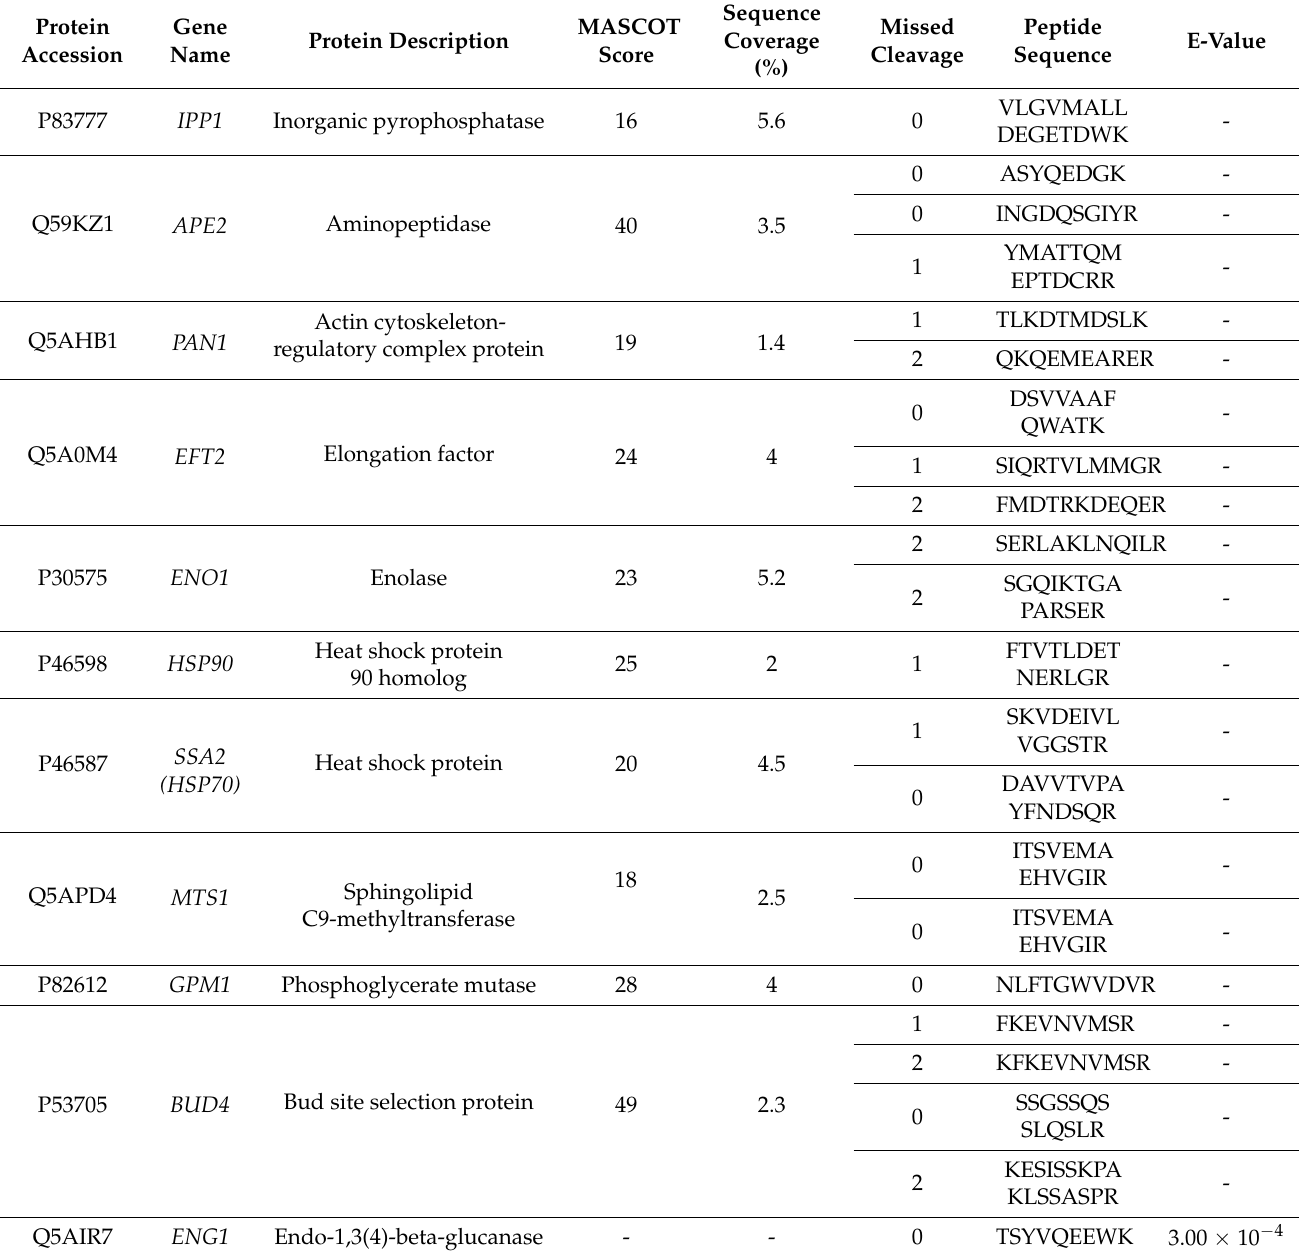
Table 1. Essential proteins and other proteins involved in growth were identified in the fluconazole-resistant C. albicans strain. Proteins identified using MASCOT are represented with sequence coverage while proteins identified using BLAST are represented with